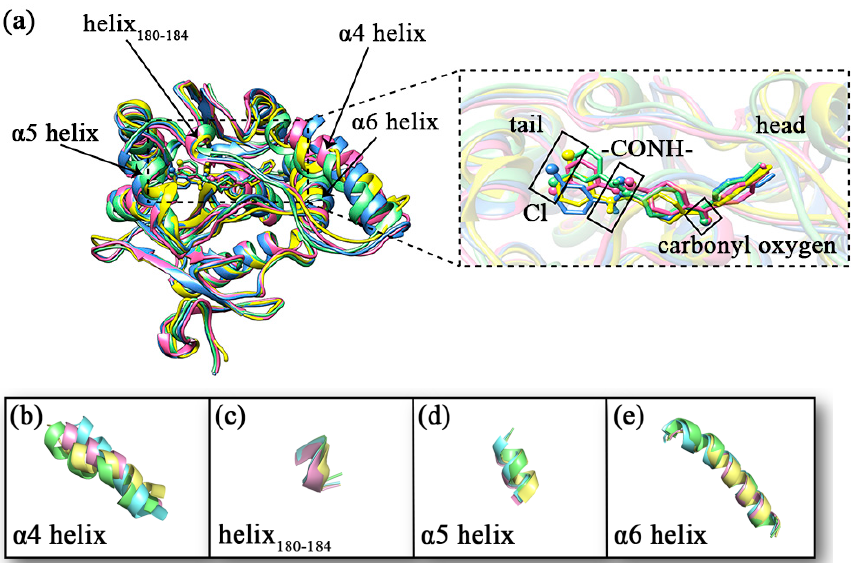
Figure 7. ( a ) The conformations of the four complexes are superimposed. The MAGL is shown in ribbon mode. The inhibitor is shown in stick mode, where the carbonyl oxygen at the head, the amide bond at the tail, and the Cl atom on the tail benzene ring are specifically shown in stick and ball mode. Complex 1 is shown in yellow, complex 2 is shown in blue, complex 3 is shown in pink, and complex 4 is shown in green. ( b – e ) A comparative diagram showing the superposition of α 4 helix, helix 180–184 , α 5 helix, and α 6 helix in the lid domain of the four complexes; yellow represents complex 1, blue represents complex 2, pink represents complex 3, and green represents complex 4. Table 1. The average values of RMSD for α 4 helix, helix 180–184 , α 5 helix, and α 6 helix in the four complexes are calculated